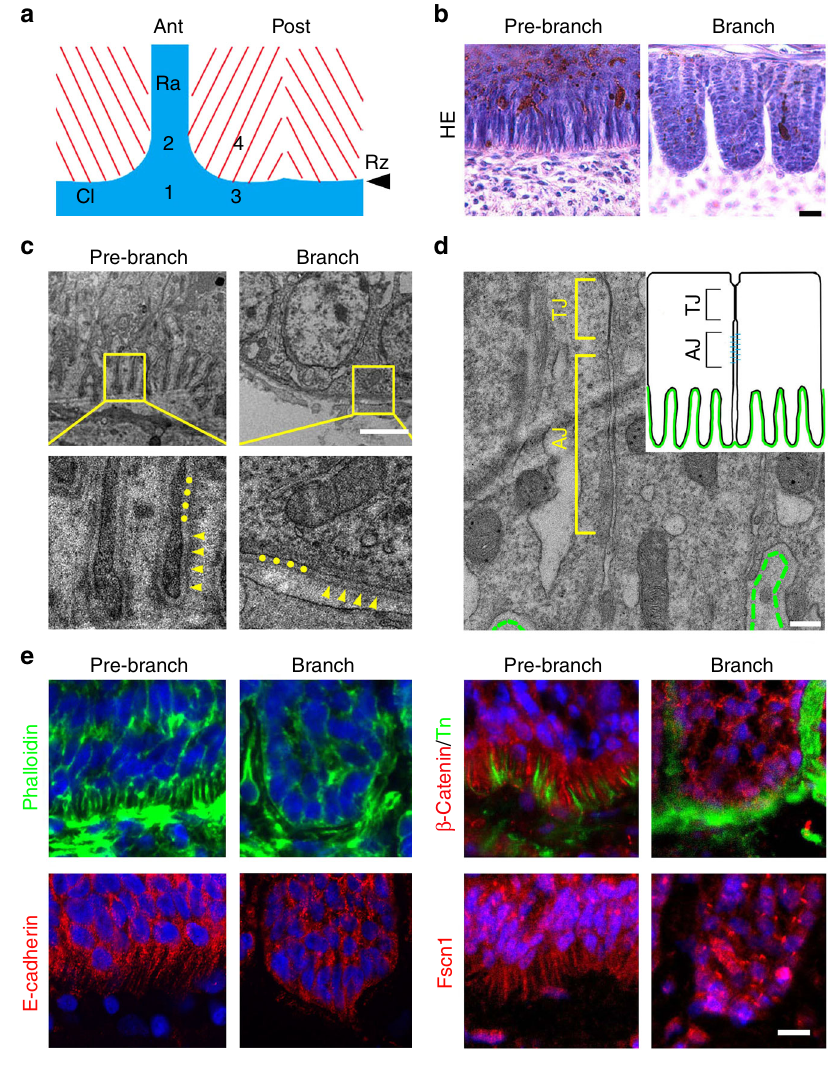
Fig. 2 Filopodia in basal keratinocytes of the feather epithelium. a A schematic diagram showing the regions examined. The proximal feather epithelium (collar, Cl; regions 1, 3) is not branched. Above the ramogenic zone (Rz), the epithelium branches along the circumference of the follicle, with the exception of the rachis in the anterior (Ra, region 2). Filopodia were found in regions 1, 2, 3 but not 4. b HE staining; c , d TEM analysis; e immuno fl uorescence showing fi lopodia in the basal keratinocytes of the pre-branch feather epithelium. Basal lamina are shown in higher magni fi cations in c , with the lamina lucida indicated by dots, and lamina densa indicated by arrow heads. Tight junction (TJ) and adherens junctions (AJ) are indicated in the basal keratinocytes ( d and inset). Dashed green line indicates the basal lamina. Representative images from fi ve repeated experiments are shown. Bar = 20 μ m in b , e , 2 μ m in c , 0.3 μ m in